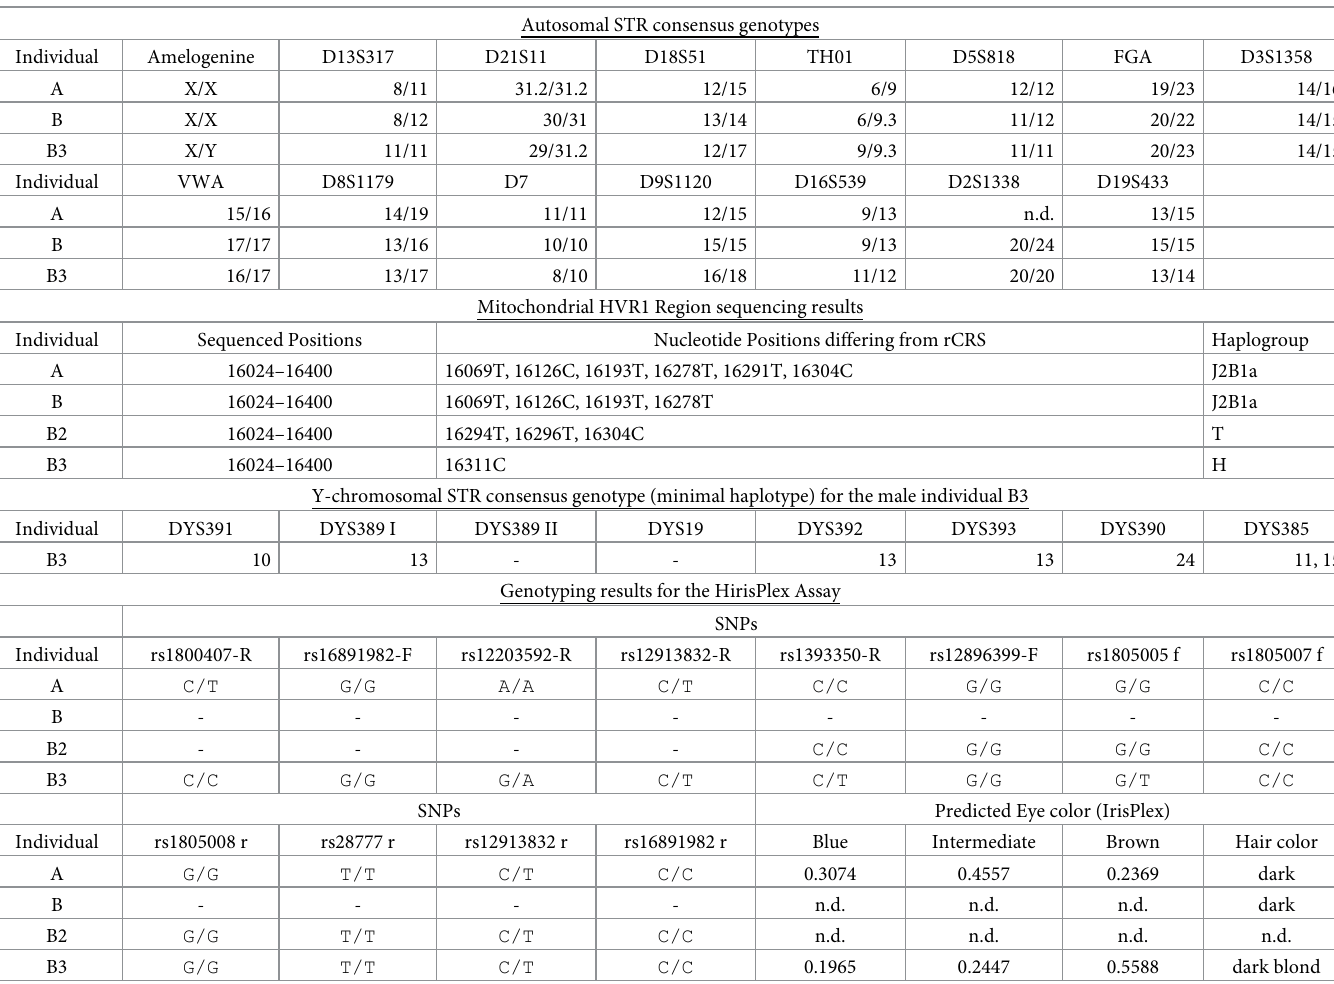
Table 2. YNH4 genotype and phenotype